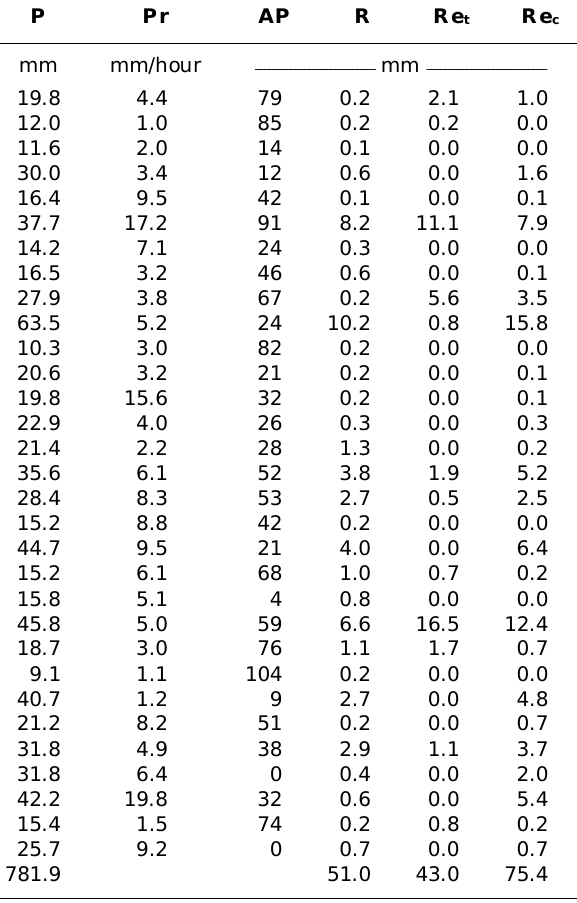
Table 2. Total precipitation (P), average precipitation rate (Pr), five-day antecedent precipitation (AP), measured runoff (R), estimated runoff for tabulated CN values (Re and estimated runoff for calculated CN values ) obtained at Capetinga (Re c